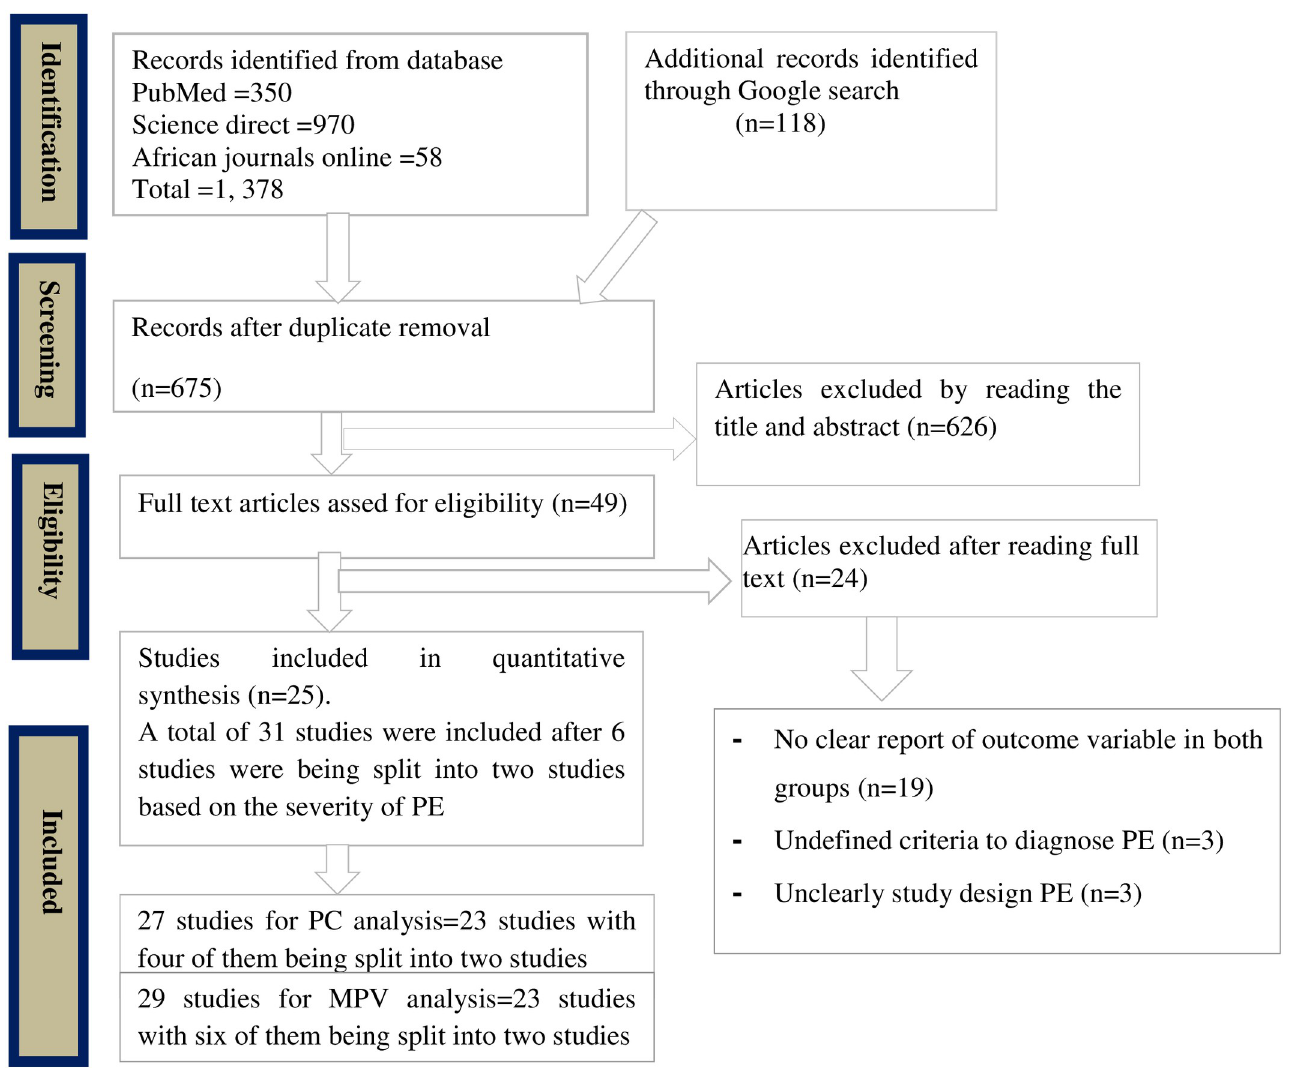
Fig 1. Flow chart to describe the selection of studies for the systematic review and meta-analysis on the association between PC and MPV with PE.